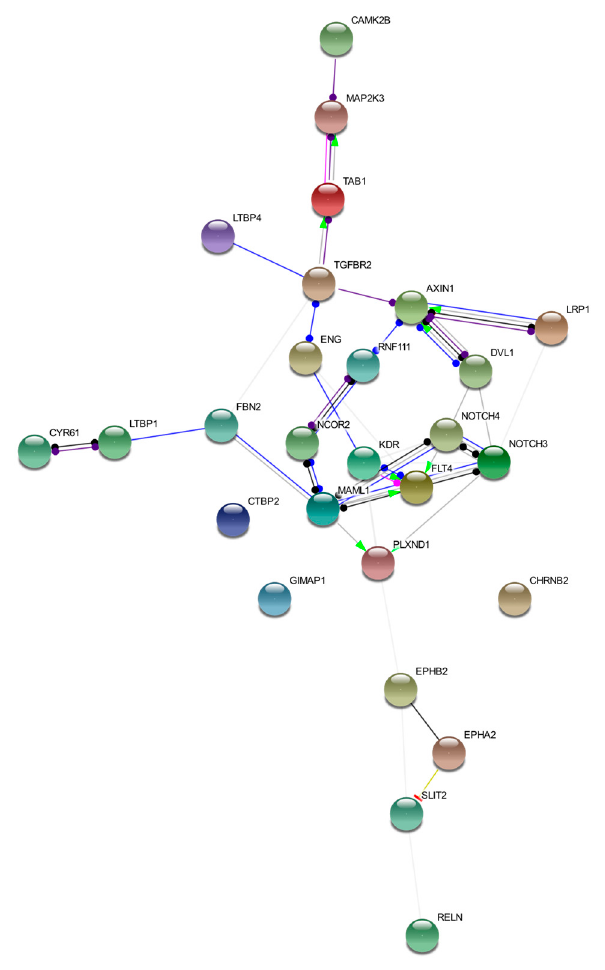
Figure 2. Functional network of prioritized genes. The image describes observed and inferred functional interactions linking prioritized genes. Nodes represent input proteins while edges represent protein–protein associations. Each edge color indicates a specific annotation. Green: activation; red: inhibition; blue: binding; light blue: phenotype; black: reaction; violet: catalysis; pink: posttranslational modification; yellow: transcriptional regulation.